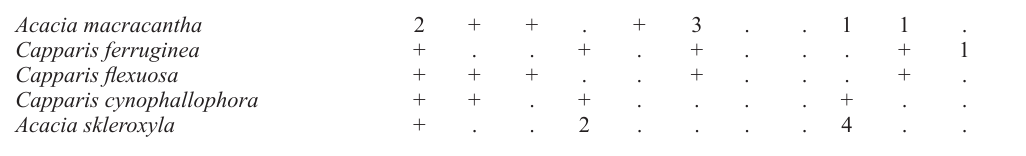
Bursera simaruba .